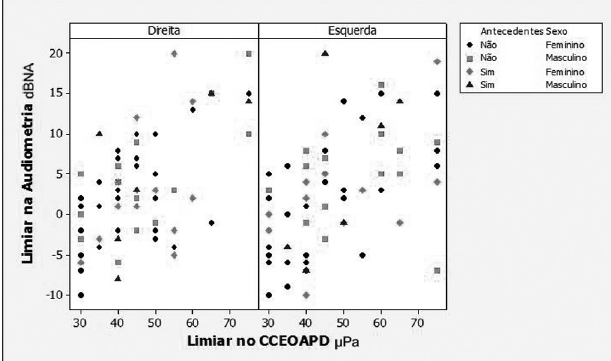
Figura 4. Diagrama de dispersão dos limiares audiométricos e dos variáveis: orelha, antecedentes de otite média e sexo - 6000